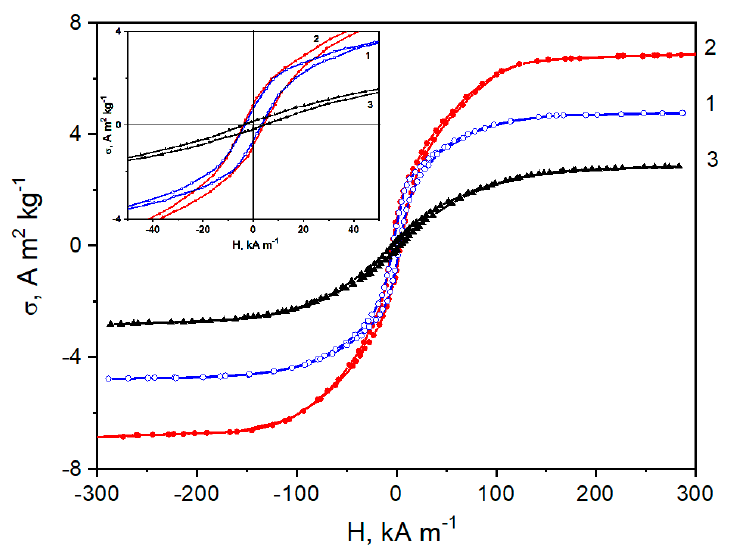
Figure 11. Hysteresis loops of the magnetic moment of composites: 1—NC1_10; 2—NC1_5; 3—NC2. In insets: range of small values of the magnetic field strength.